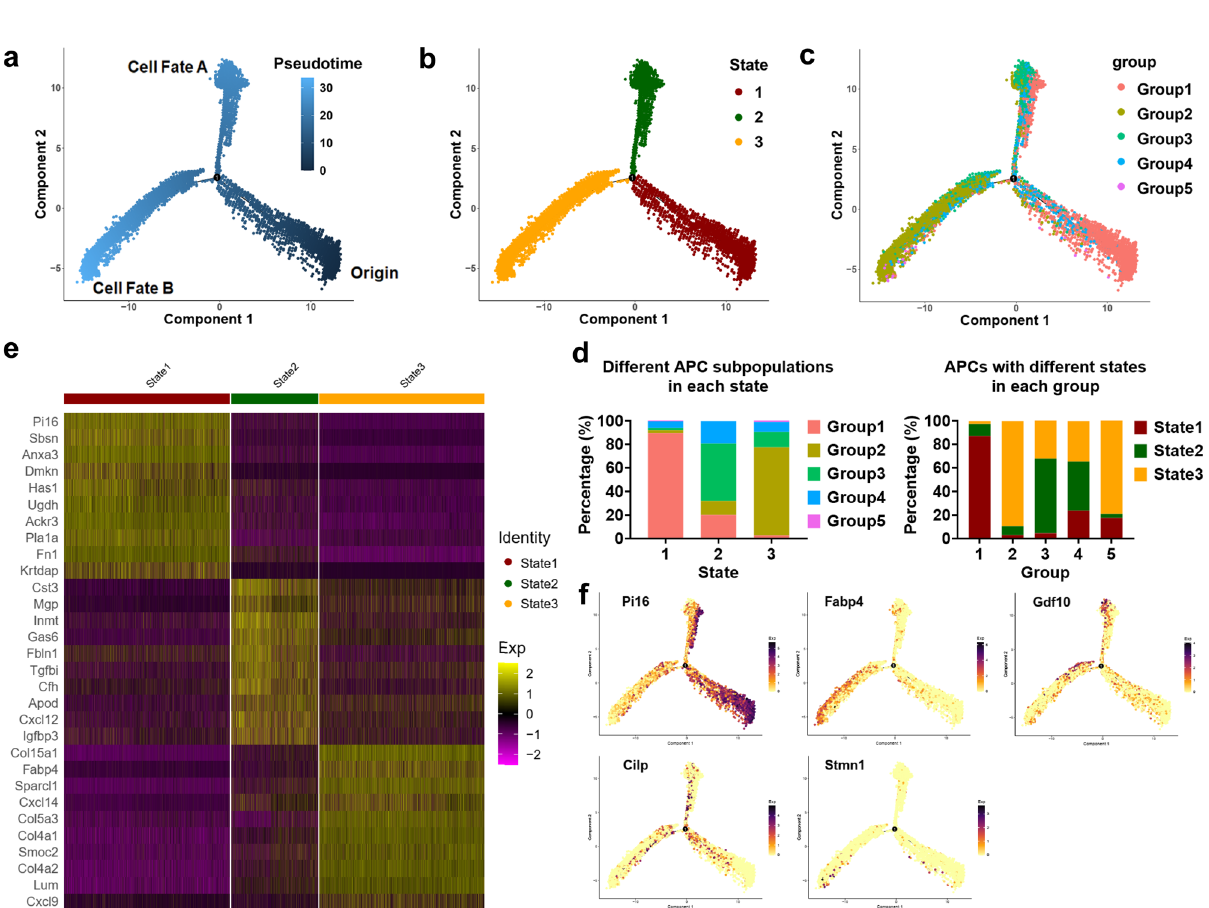
Fig. 6 Pseudotime developmental trajectories of APCs in iBAT. a – c Pseudotemporal cell ordering along trajectories of APCs in iBAT. Pseudotime is depicted from dark to light blue ( a ). Cells were classi fi ed into 3 states ( b ). Group identities were overlaid on pseudotime trajectory map ( c ). d Stacked bar chart showing the abundance of cells from distinct groups in 3 states or from distinct states in 5 groups. e Heatmap of DEGs between different states. Top 10 DEGs and their scaled expression are shown. f Feature plots of expression distribution for group markers across pseudotime. Source data are provided as a Source Data fi